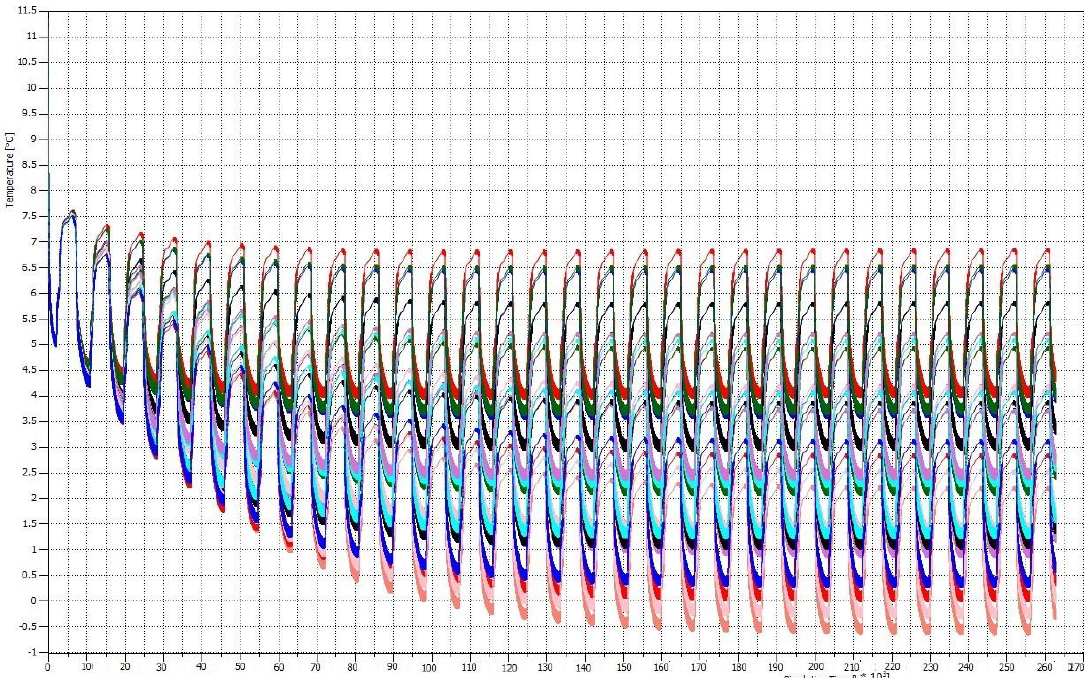
Figure 7. Average temperature of BHEs within the 1st scenario (system without space cooling) during 30 years of operation.